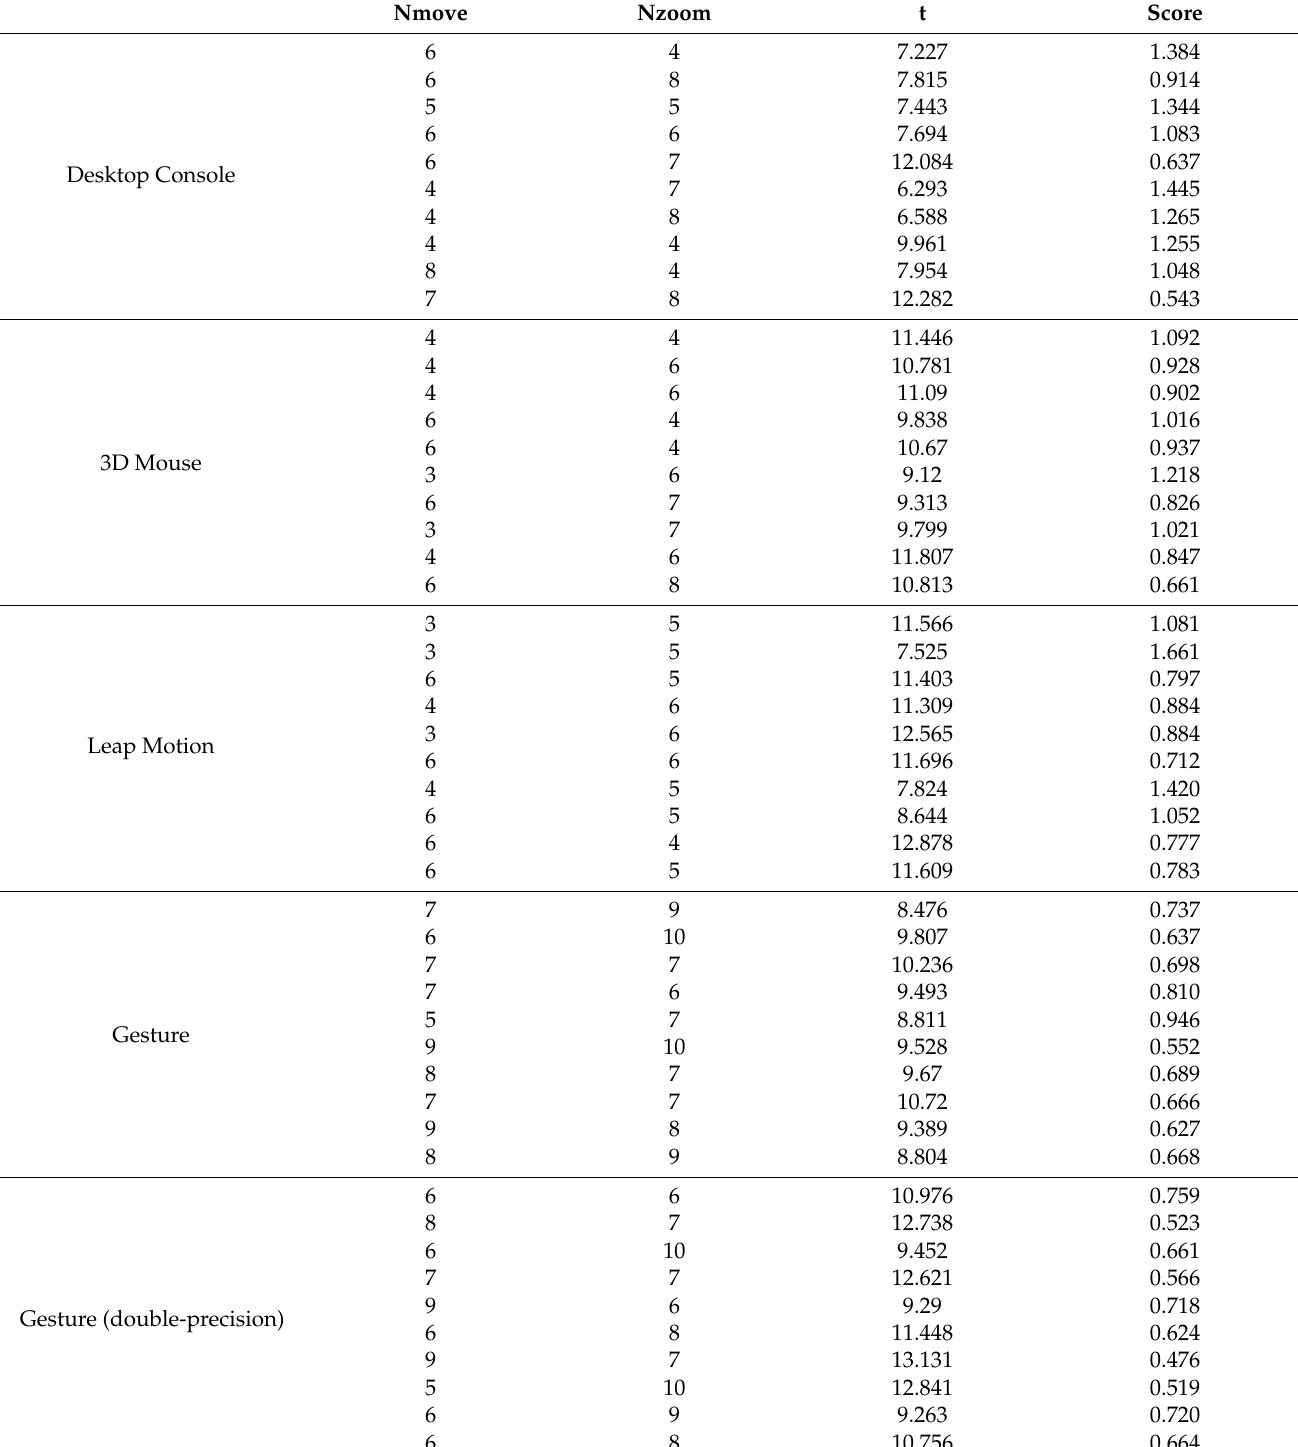
Table 4. Experimental results of navigation